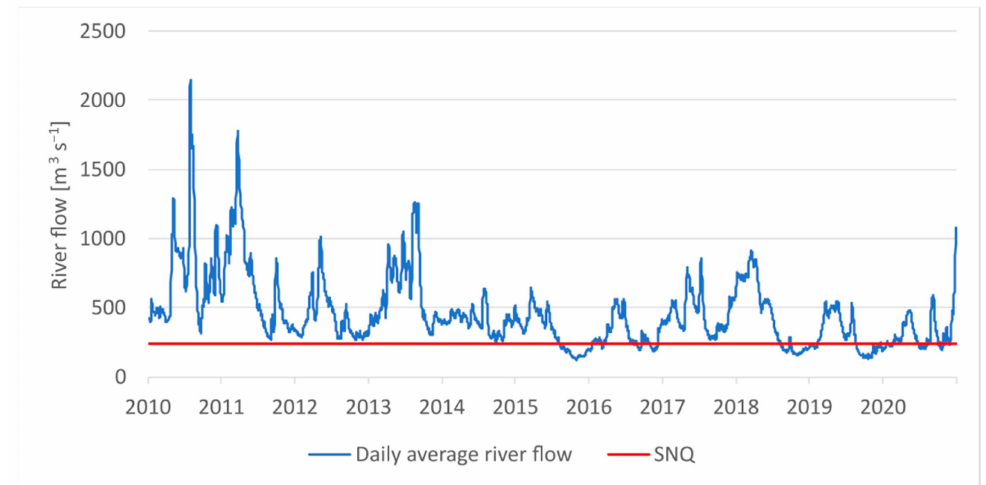
Figure 5. The flow of the Odra River at the location of the Gozdowice water gauge station in the hydrological years 2010–2020.